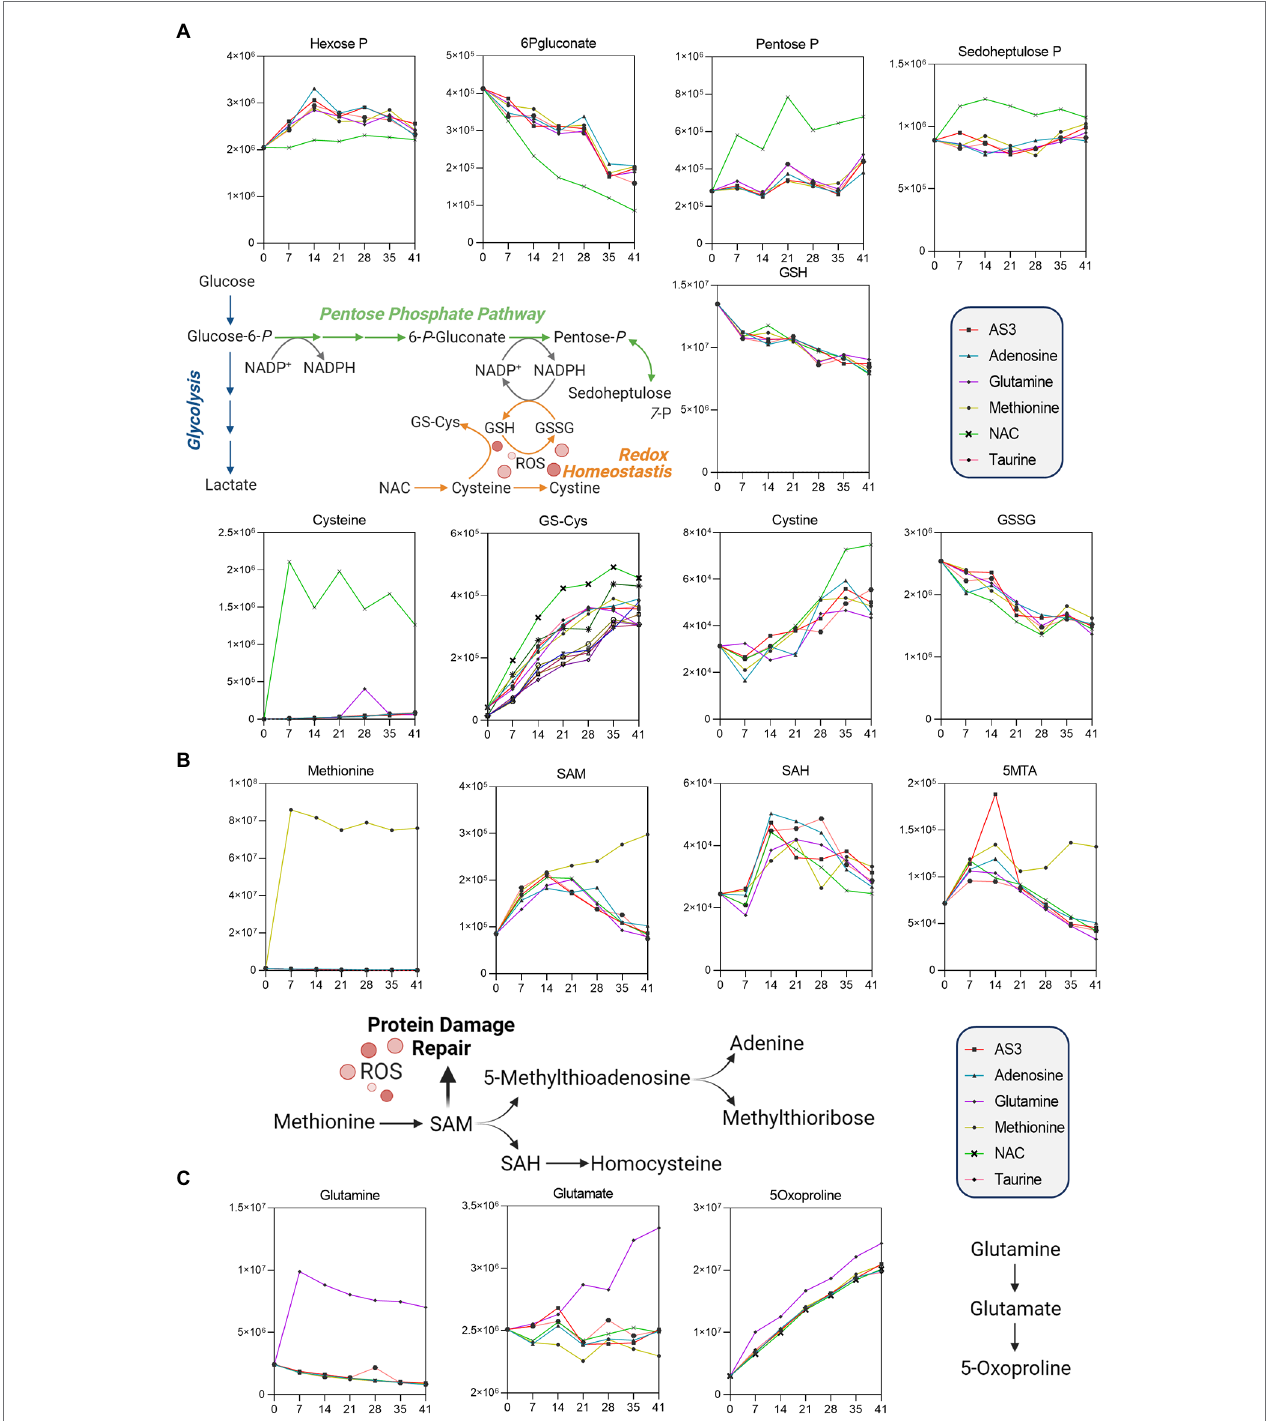
FIGURE 3 | Significant impact of (A) NAC on the pentose phosphate pathway, (B) methionine on methylation/purine salvage, and (C) glutamine on 5-oxoproline